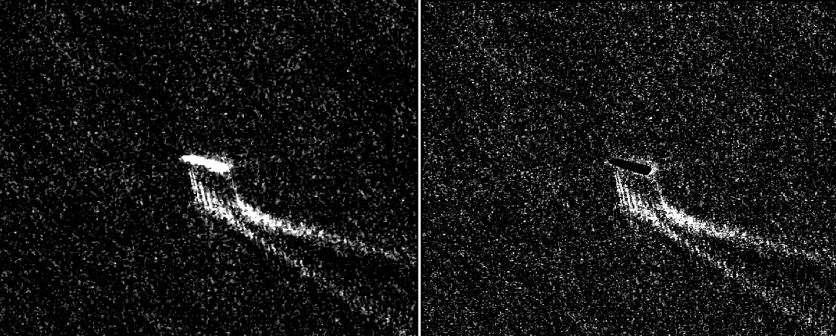
Figure 8. Exploitation of the ship footprint returned by a ship segmentation module.